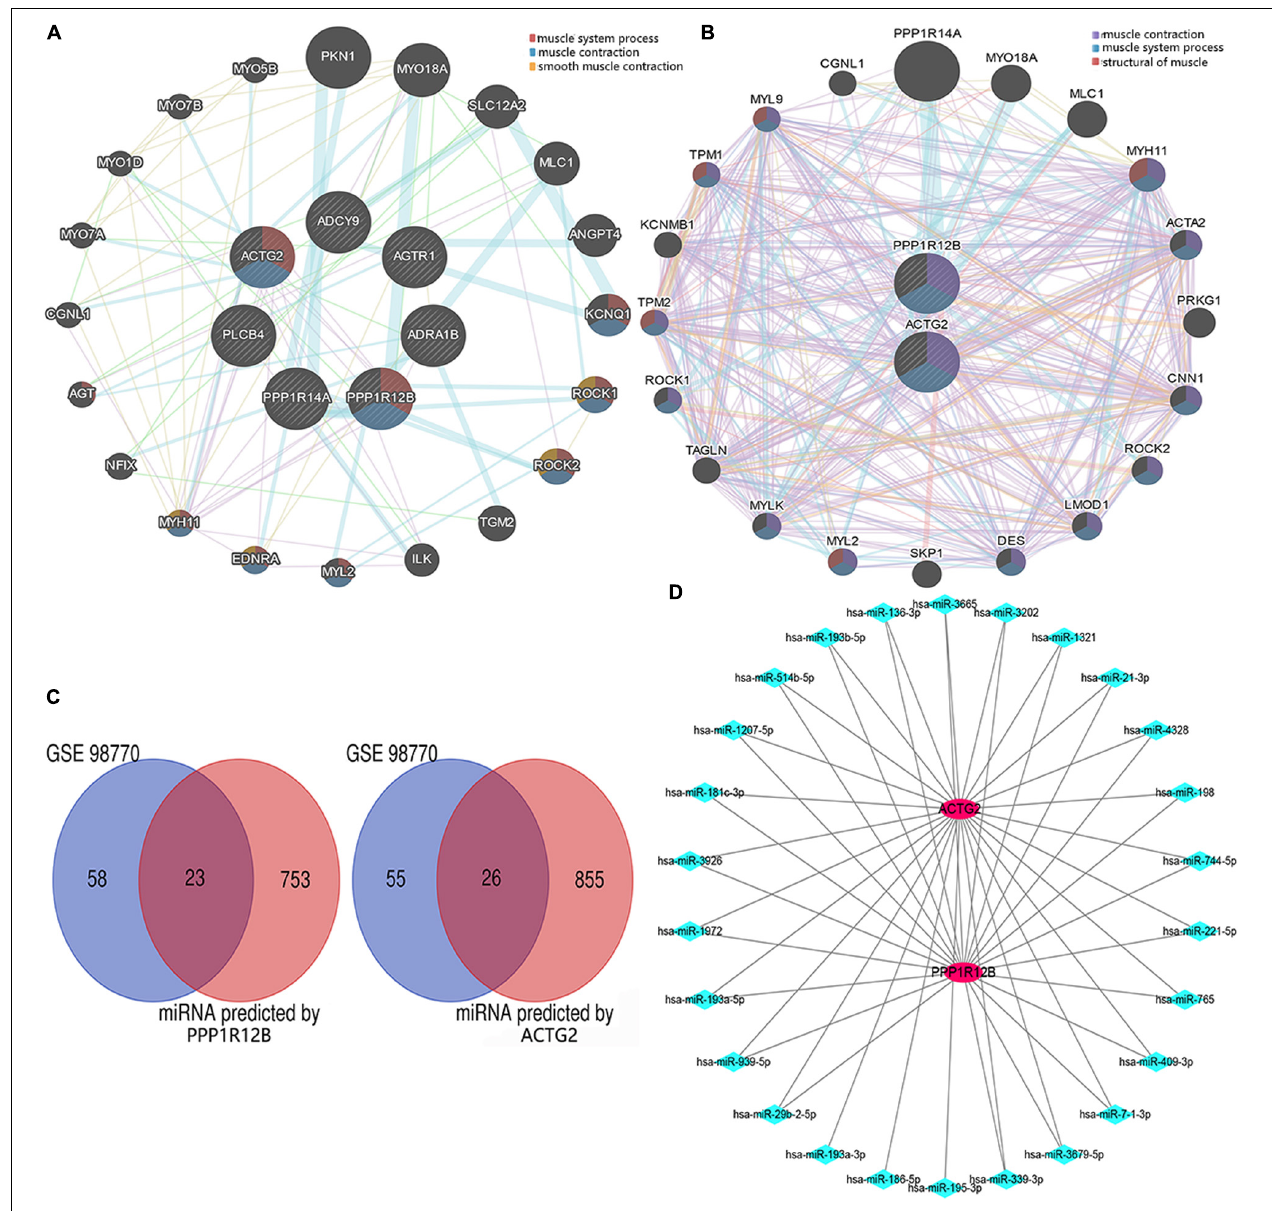
FIGURE 3 | The interactome of DEGs. (A) Protein–protein interaction networks of the DEGs associated with the eight genes (MYH11, EDNRA, MYL2, ROCK2, ROCK1, and KCNQ1) relevant with vascular smooth muscle contraction pathway. (B) Protein–protein interaction networks of DEGs (ACTG2 and PPP1R12B) associated with vascular smooth muscle contraction. (C) Venn diagram for the DEGs (including PPP1R12B and ACTG2) in the GSE98770 dataset. (D) The miRNA–mRNA network. There were 25 and 2 differentially expressed miRNAs and mRNAs, respectively that were associated with vascular smooth muscle contraction. The red circles and blue diamonds represent the miRNAs and mRNAs,